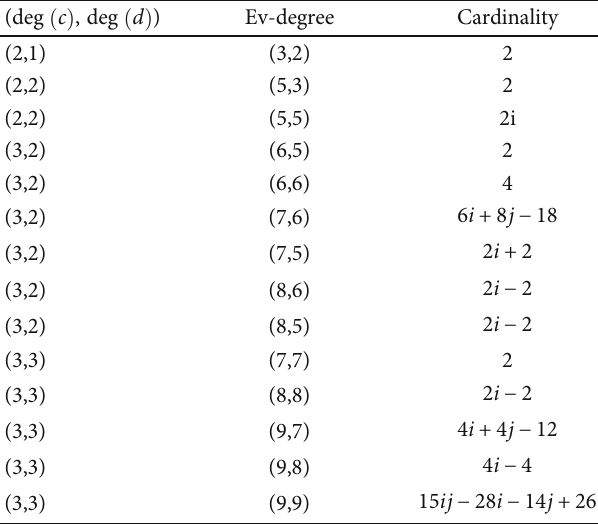
- II ½ i , j (cid:2) . 4